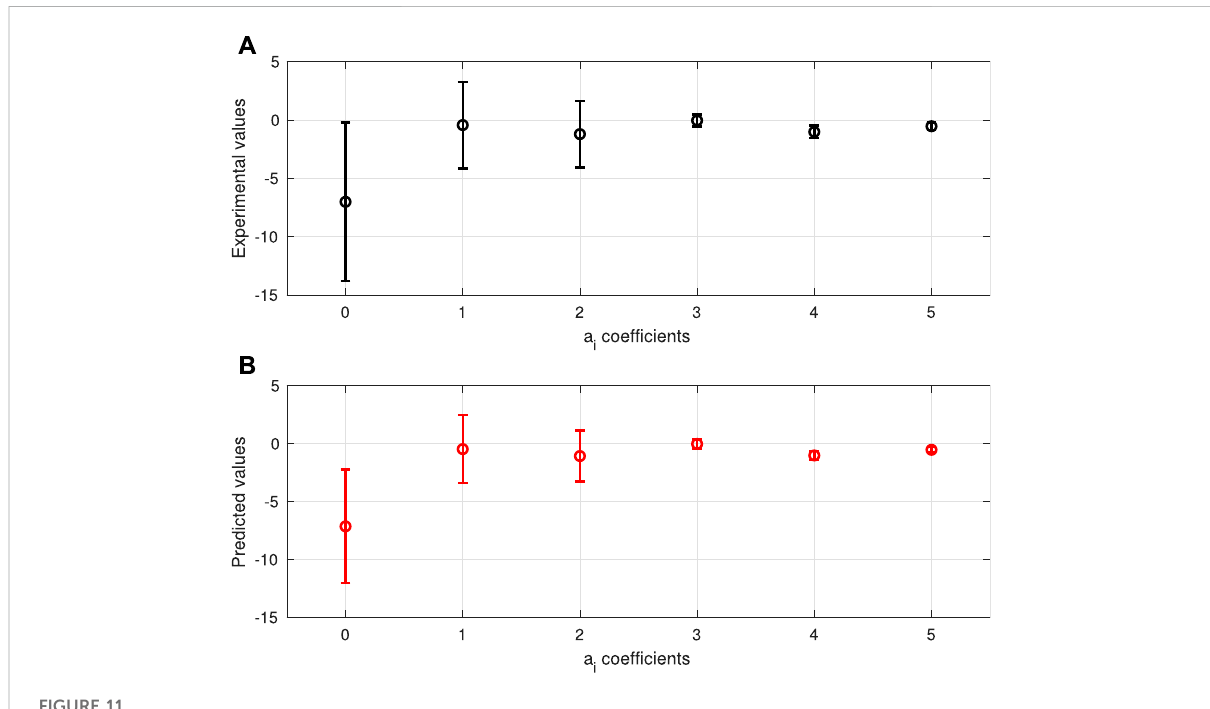
FIGURE 11 Model performance with respect to the validation data: (A) : the mean and standard derivation values of the experimental a i values (obtained in Section 3.1) and (B) : those of the predicted a i values using Eq. 10.